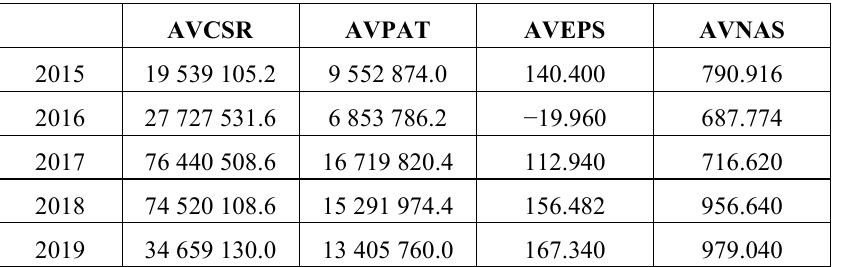
Table 3. Average Values of the Variables of the Study as Computed from